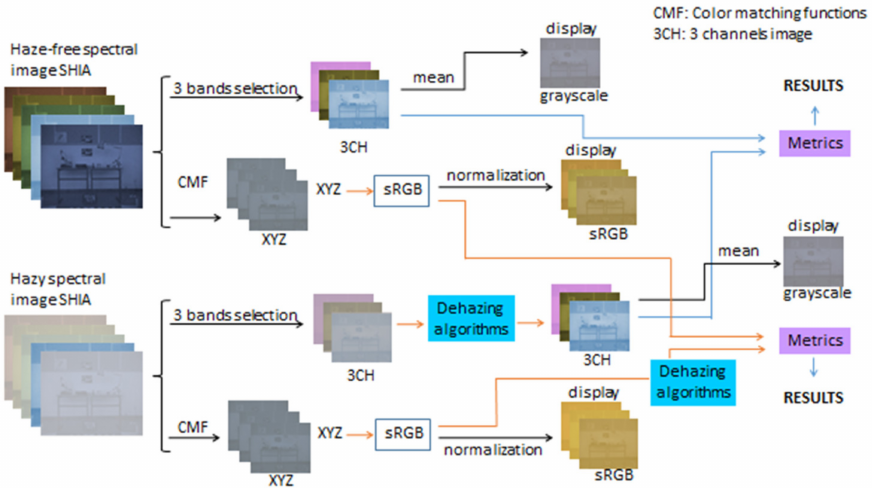
Figure 1. Schematic workflow of the study.